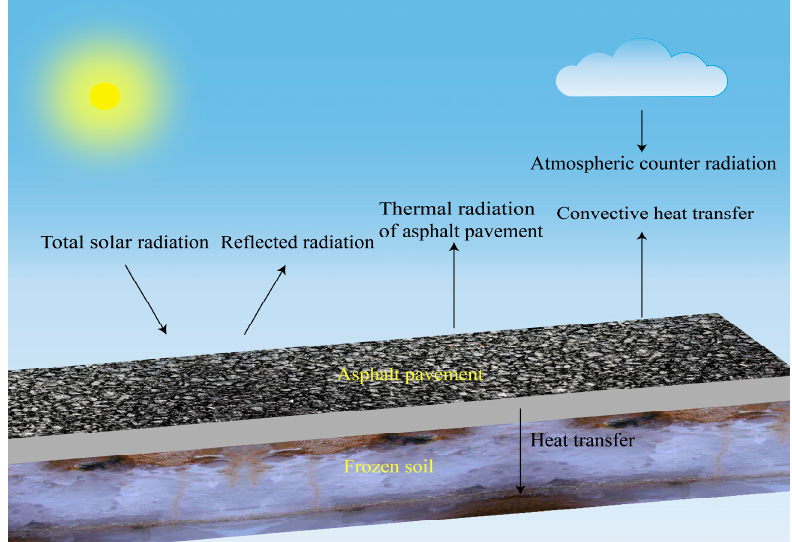
Figure 2. The environment for asphalt pavement.